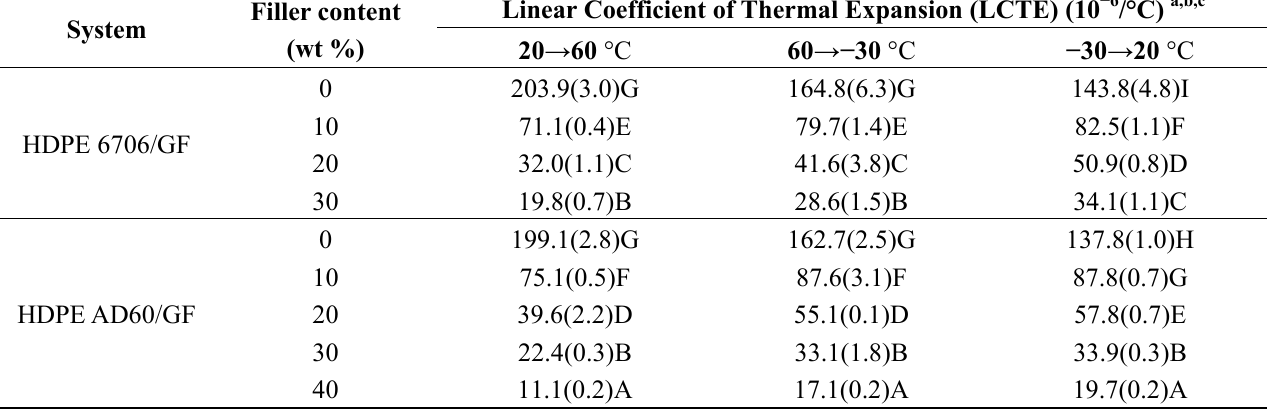
Table 2. Summary of thermal expansion properties of virgin HDPE and filled HDPE composites with individual glass